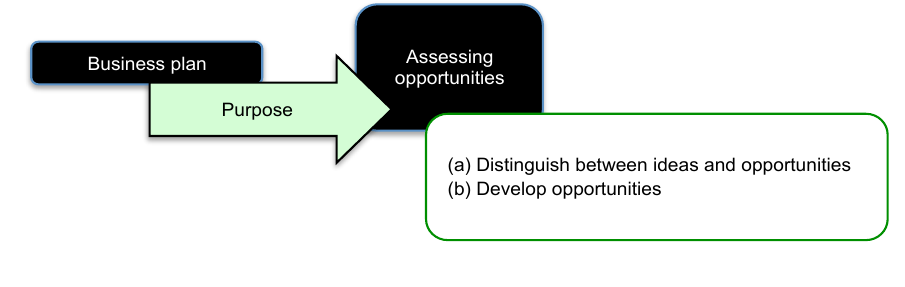
Hypothesised purpose for a business plan Assessing